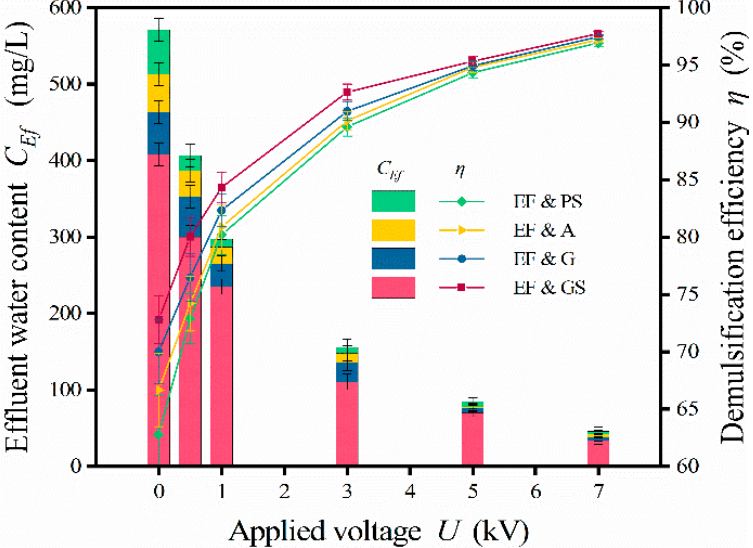
Figure 10. Effect of wettability. Conditions: C in = 1500 mg/L; v = 0.001 m/s; U = 0–7 kV; PS, A, G, and GS medium bed with size of 1.0–2.0 mm and L * = 20